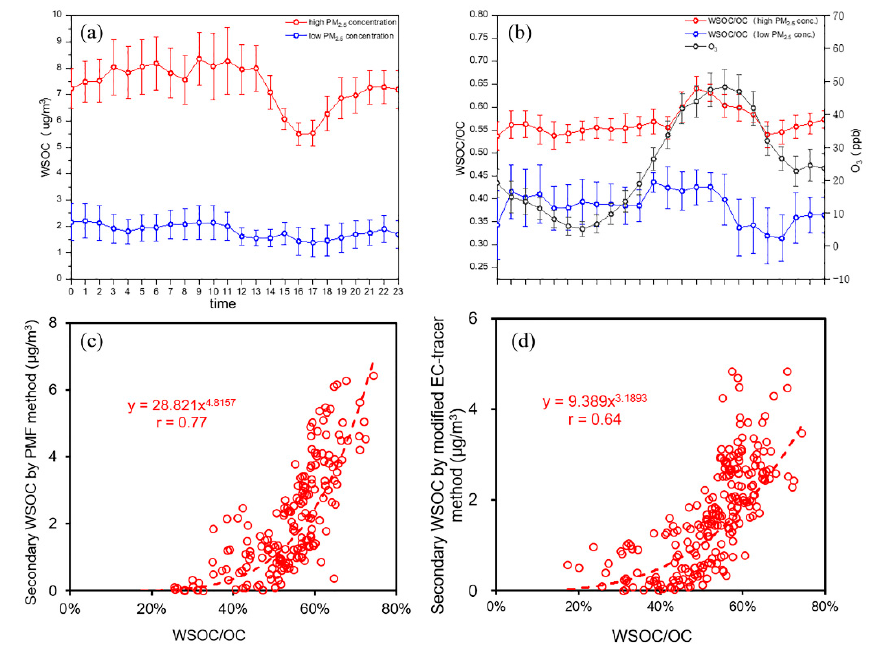
Figure 8. Diurnal variations of ( a ) WSOC and ( b ) WSOC / OC ratio under high and low PM 2.5 concentrations and average concentration of O 3 ; and correlations between the WSOC / OC ratio with secondary WSOC calculated by ( c ) PMF results and ( d ) modified EC-tracer method. Note: High PM 2.5 concentration condition is defined by days with daily PM 2.5 concentration higher than 75 µ g / m 3 , while those lower than 75 µ g / m 3 are defined as low PM 2.5 concentration condition.